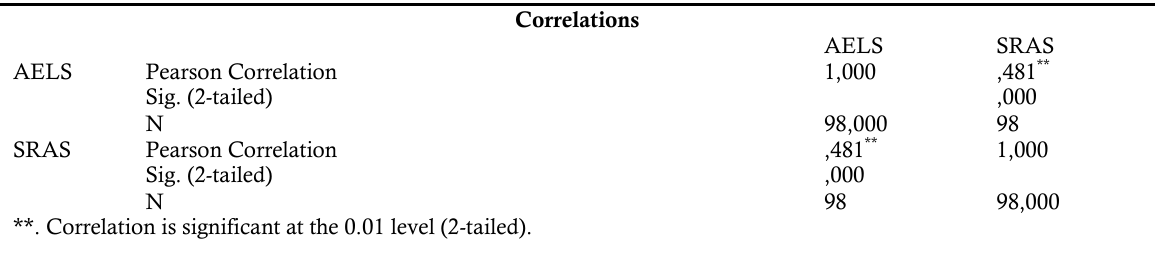
Table 2. Correlation between active-empathic listening and altruism Correlations